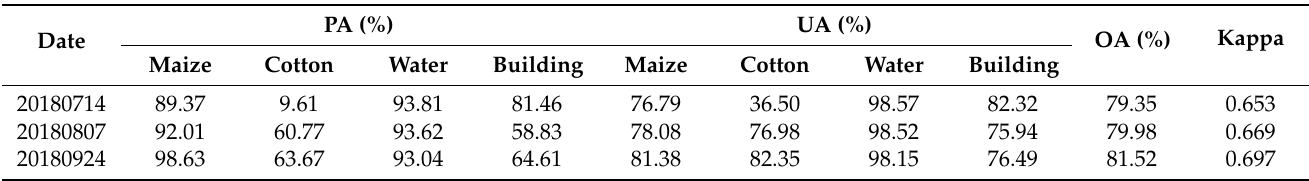
Table 6. Accuracies and Kappa coefficients of the classification of 4 land-cover types using 39 features and the random forest algorithm.